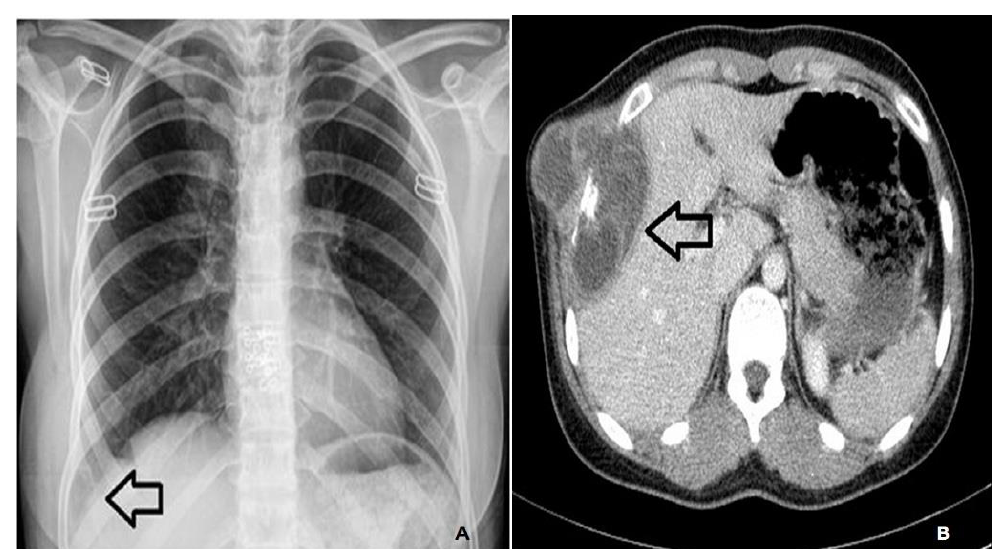
Figure 1. Posteroanterior view of chest X-ray (A) and conventional view of computed tomography scan (B) before operation